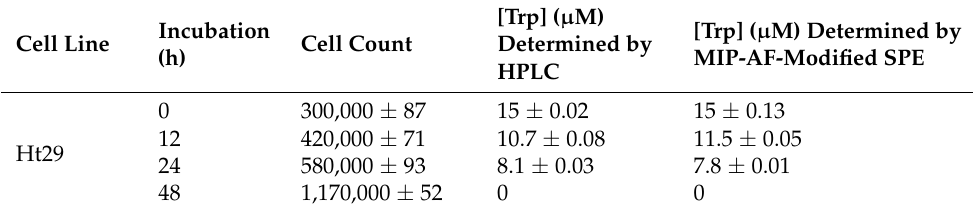
Figure 7. MIP-AF determination of Trp in the HT29 cell media incubated under different cellular culture periods; ( a ) Nyquist plot of Trp in PBS (black dots) and in HT29 cell culture media (fresh, after12, 24, 48 h); ( b ) decline in R ct with consumption of Trp in media of the cells cultured for two days. Table 2. Determining Trp in human HT29 cancer cell culture media samples ( n = 5) by HPLC and EIS with MIP-AF.